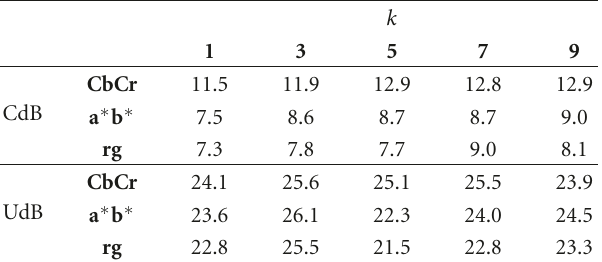
Table 1: HTER values for GMM at EER working point with increasing number of